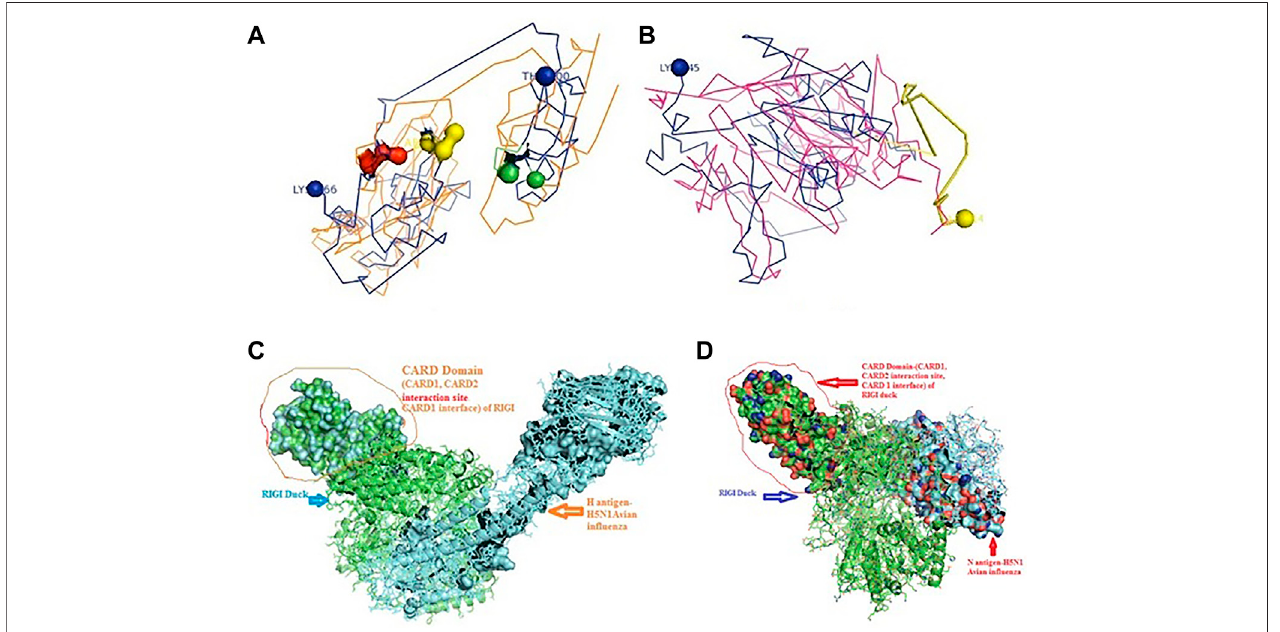
FIGURE5| Molecular docking ofRIGIwithsurfaceantigenforavianin fl uenza. (A) MoleculardockingimageRIG1ofduckwithantigen(AI) ligandHantigen-binding sitedetection. (B) MoleculardockingimageRIG1ofduckwithantigen(AI)NSantigenligand (left) andbindingsite (right) . (C) DuckRIGImodelbindingwithH-antigenof avian in fl uenza virus, with CARD domain — no binding for CARD with virus. (D) Duck RIGI model binding with N-antigen of avian in fl uenza virus, with CARD domain — no binding for CARD with